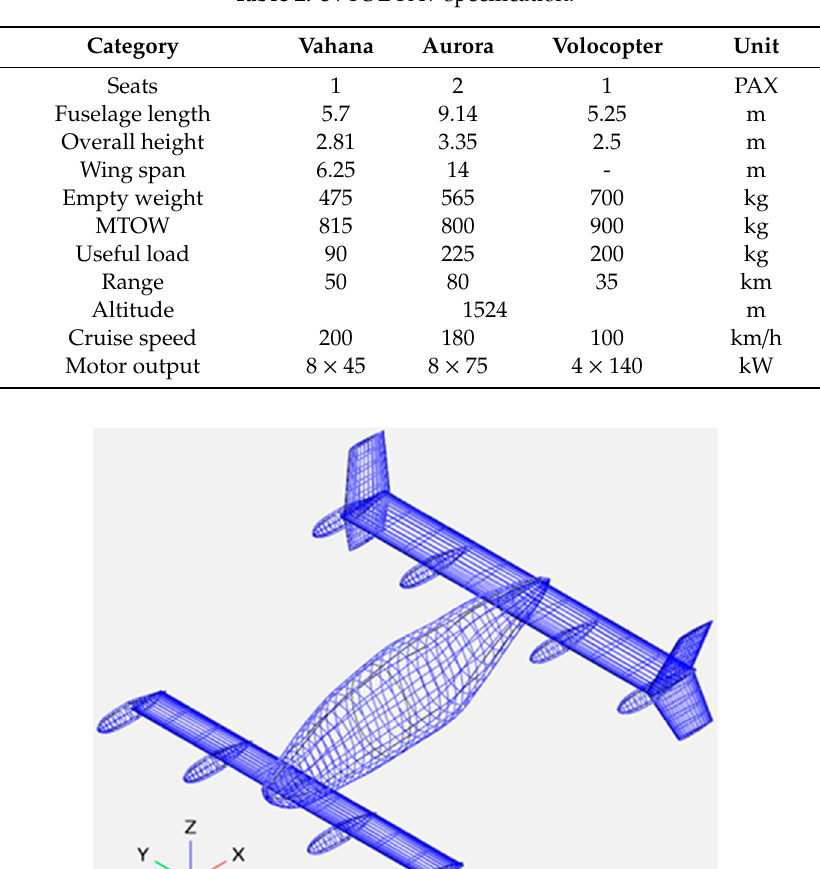
Figure 1. Vahana configuration using OpenVSP. Table 6. Flat-plate skin friction coefficient of Vahana.